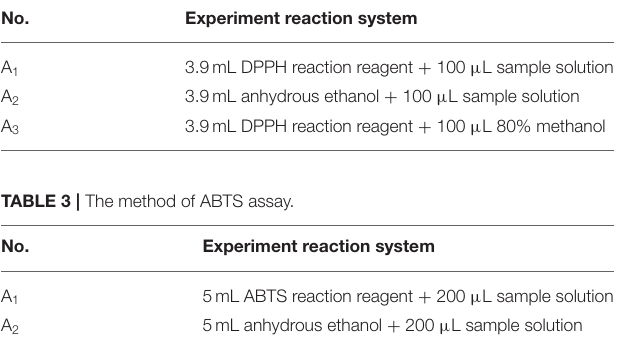
TABLE 2 | The method of DPPH assay. No.